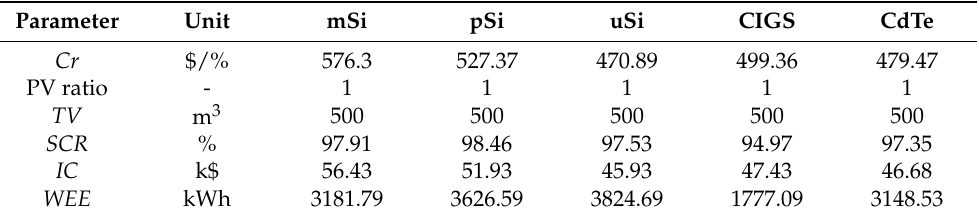
Table 5. Optimal configurations for each PV cell technology for cherries in Silistra with a 15 kW HRES, using a WT type